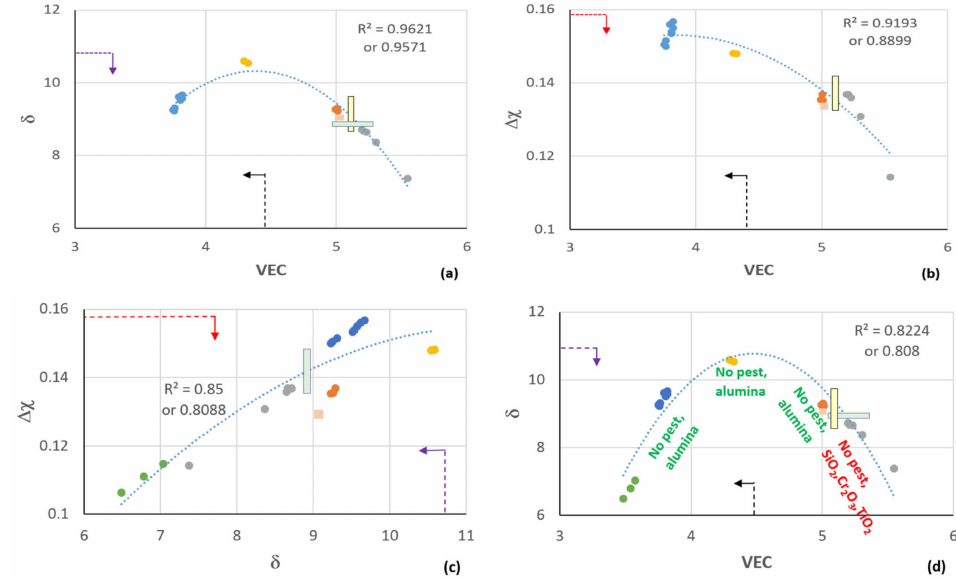
Figure 1. Maps of the parameters δ , ∆ χ , and VEC for the alloys OHC2 (orange), OHC1 (grey), OHC5 (gold), MG5, MG6, MG7 (blue), and Zone A in alloy MG7 (green): ( a ) δ versus VEC, ( b ) ∆ χ versus VEC, ( c ) ∆ χ versus δ , ( d ) δ versus VEC. Data points for Zone A in OHC2 are shown by squares. For the yellow and green boxes and dashed lines and arrows, see text. ( a – d ) The lower R 2 value is for data that includes Zone A of the alloy